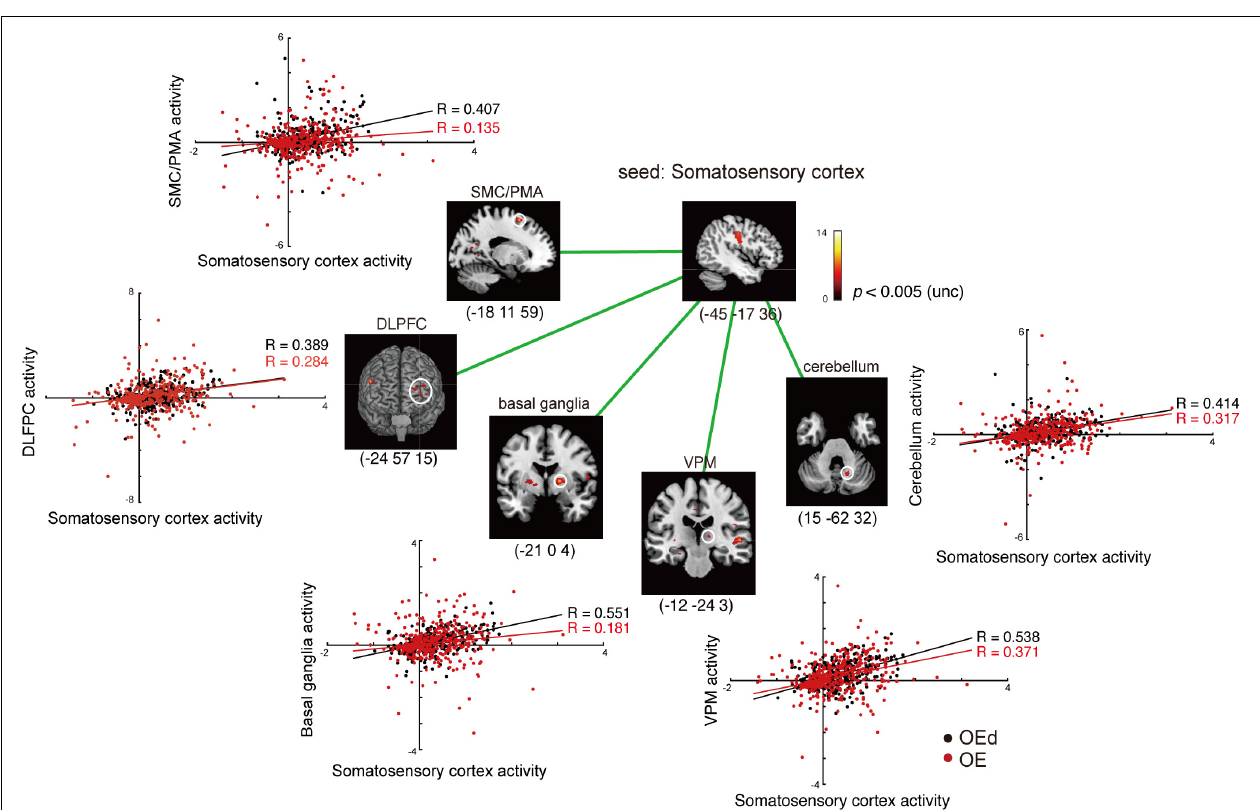
FIGURE 7 | Results of the functional connectivity/PPI analysis. Tapping with denture wearing enhanced the effective connectivity from the SI to the thalamus (VPM), basal ganglia (putamen), SMC/PMA (=BA6), cerebellum, and DLPFC ( p < 0.05, uncorrected). The location superimposed on a template of the seed region and the target regions shows a response that was significantly associated with stronger connectivity with the seed region under OE (red dots) vs OEd (black dots) conditions. The color bar shows t -values. Scatterplots show the regression of activity in the VPM, basal ganglia (putamen), BA6, cerebellum, and DLPFC on the activity in the seed region SI/MI during tapping in the OE vs OEd groups. For each condition, the correlation coefficient between the activity in the seed and target is indicated.